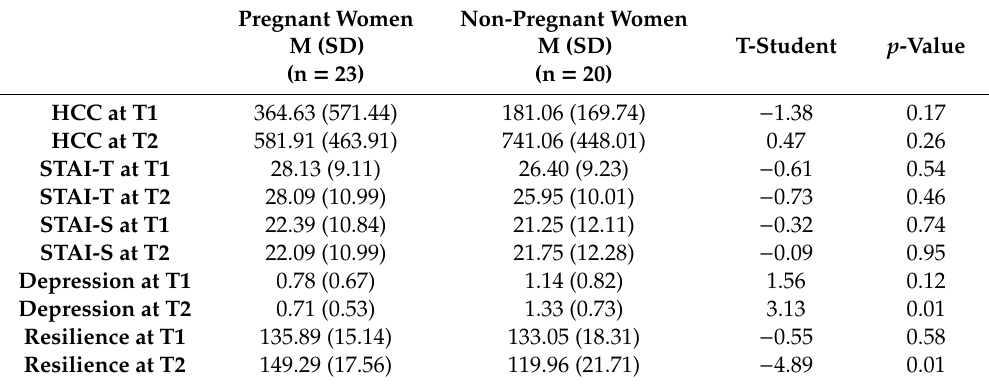
Table 2. Hair cortisol concentrations and psychological symptoms among pregnant women and non-pregnant